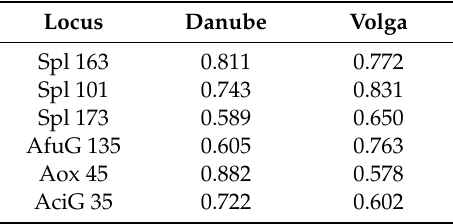
Table 2. Allele diversity per locus and population. Locus Danube